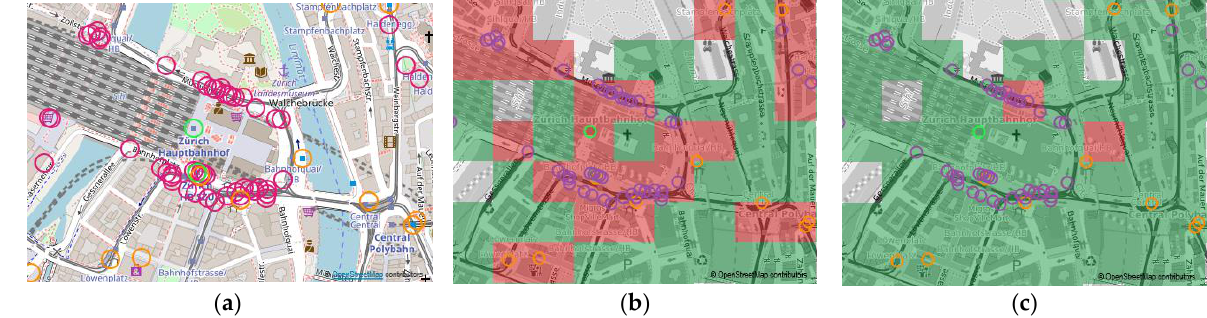
Figure 3. The topo-semantic consistency error grids are calculated from POI errors (Zurich) ( a ), as is “Consistency Grid (error existence)” ( b ). If an error exists in the grid cell, the grid cell is marked as an error. In “Consistency Grid (most frequent)” ( c ), the grid cell is marked according to the most frequent value (error or correct).